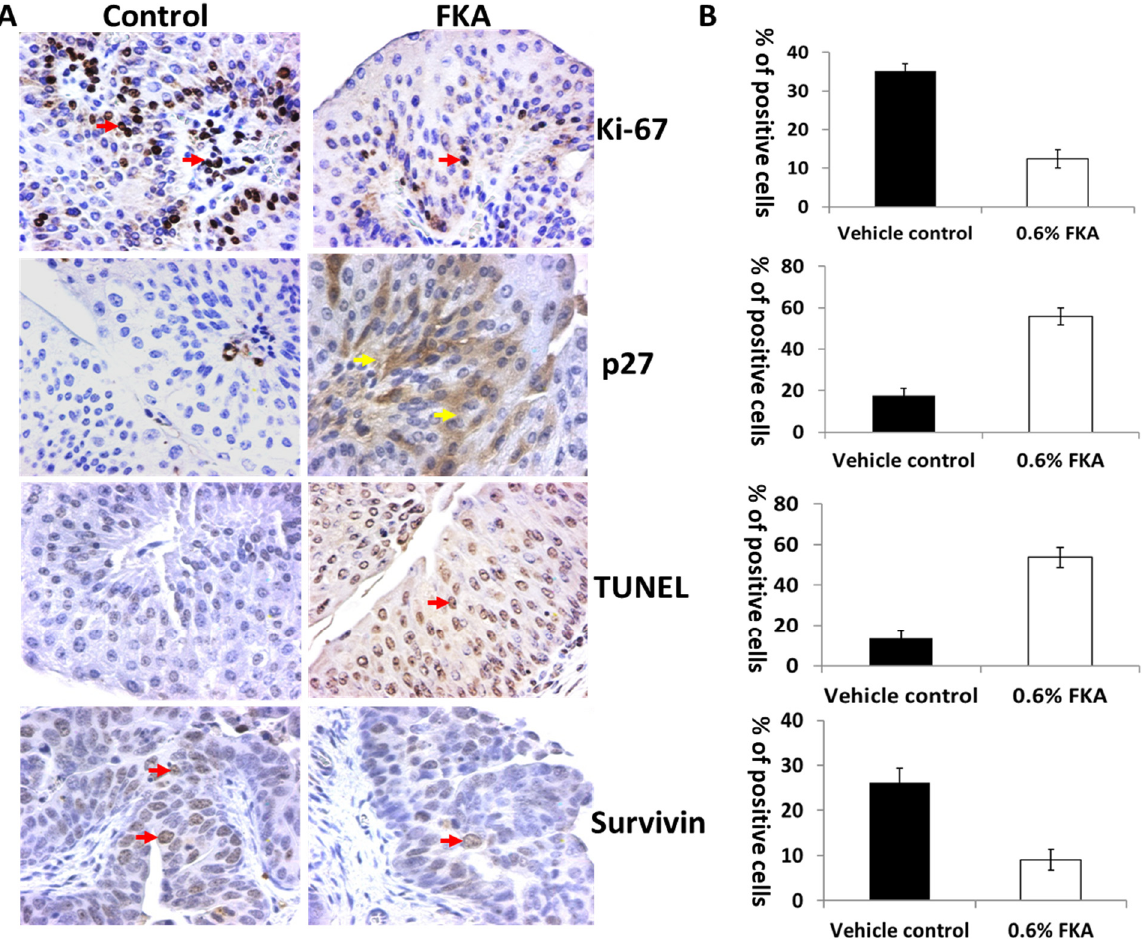
Figure 6. The in vivo mechanisms of dietary FKA in chemoprevention of urothelial carcinogenesis. Bladder tumor sections of 6 randomly selected individual mice from mice fed control or FKA diet for IHC staining of proliferation markers (Ki- 67 and p27/Kip1) and apoptotic markers (TUNEL and survivin) expression. ( A ) Representative DAB-stained tissue sec- tions from control- and 0.6% FKA-fed groups showing brown-colored positive cells are depicted at ×200 magnification. ( B ) Positive-staining cells were counted in 12 fields in each group. The percentage of positive cells was calculated and presented as mean ± SD in histography; Student’s t-test, all p -values < 0.01. Ki-67, TUNEL, and survivin showed nuclear staining (red arrows), whereas p27 staining was in the cytoplasm (yellow arrows).